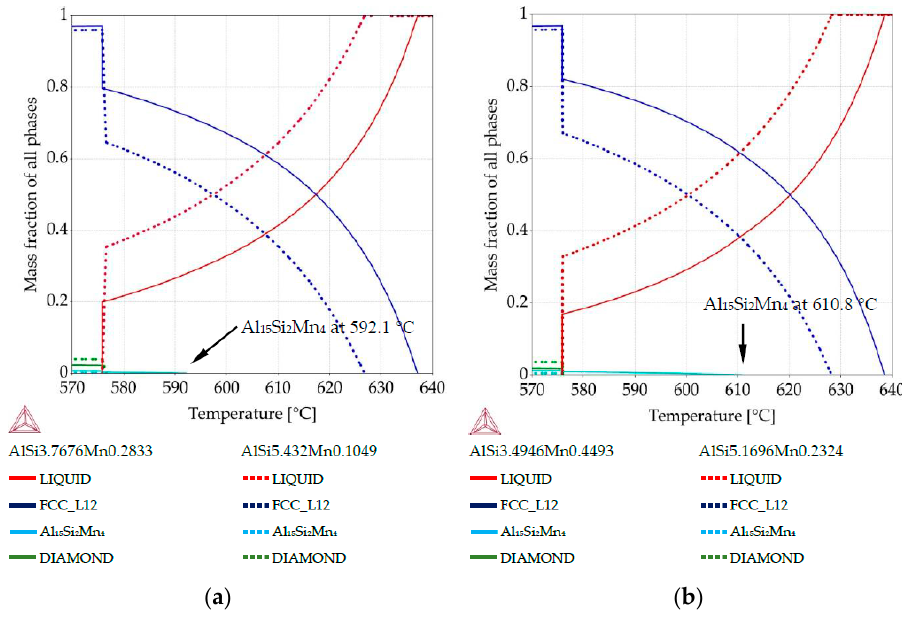
Figure 6. Property diagrams: ( a ) property diagram for AlSi5Mn0.2 specimen, for places with chemical composition AlSi3.76Mn0.28 and AlSi5.43Mn0.10; ( b ) property diagram for AlSi5Mn0.4 specimen, for